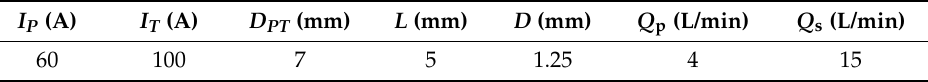
Table 2 Experimental conditions for arc pressure measurement. Table 2. Experimental conditions for arc pressure